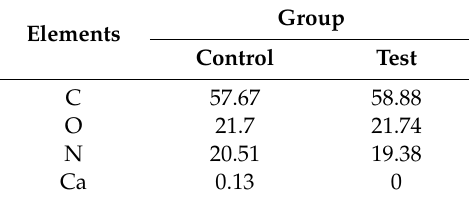
Table 1. Atomic percentages of the two membrane types as determined by EDS (%).